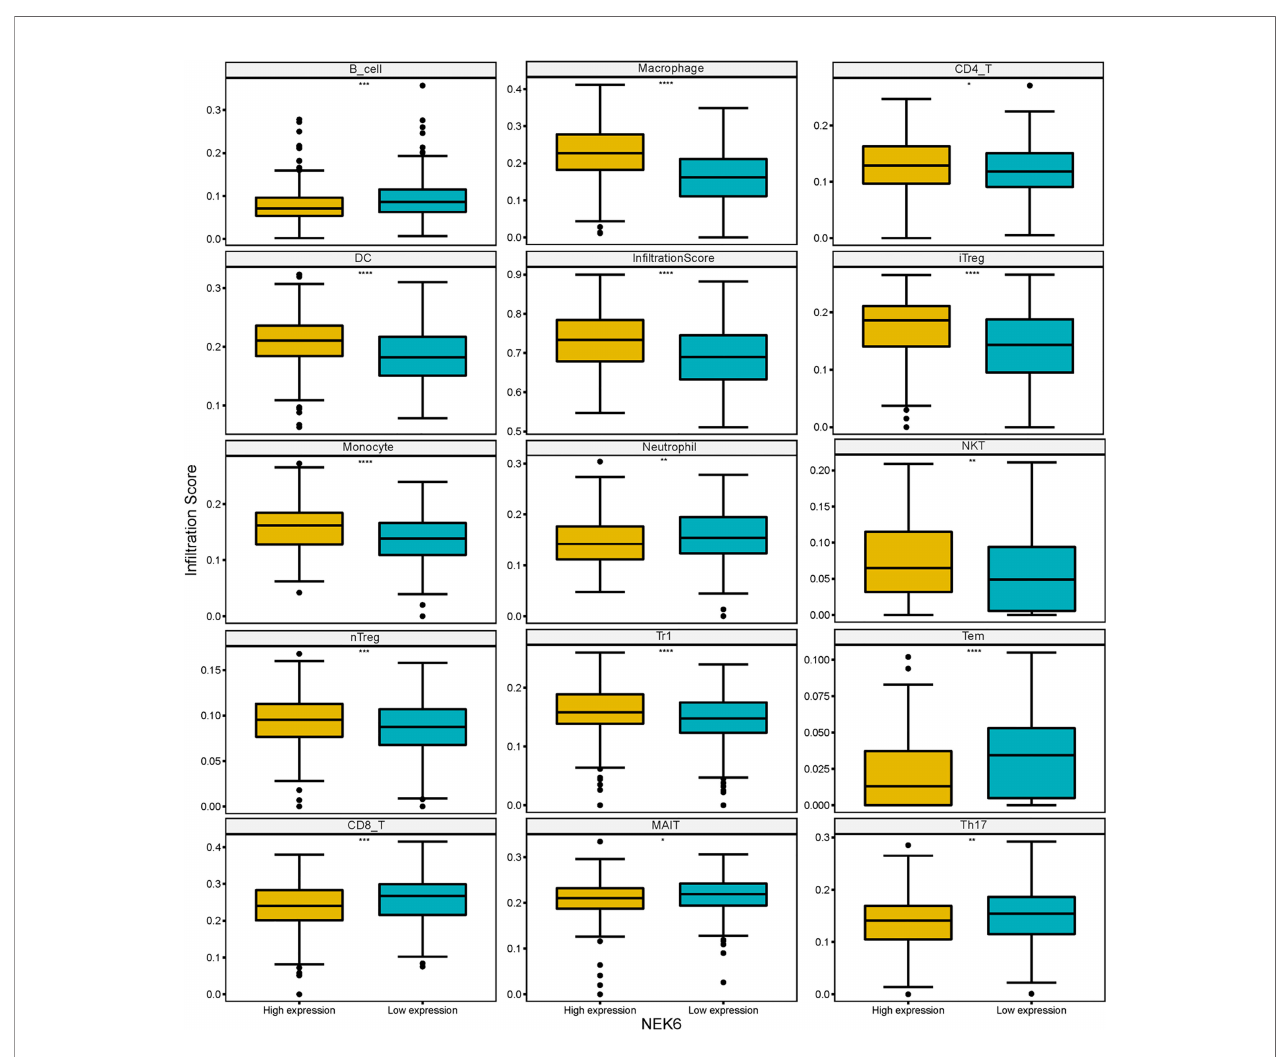
FIGURE 5 | Immune in fi ltrating cells associated with NEK expression in